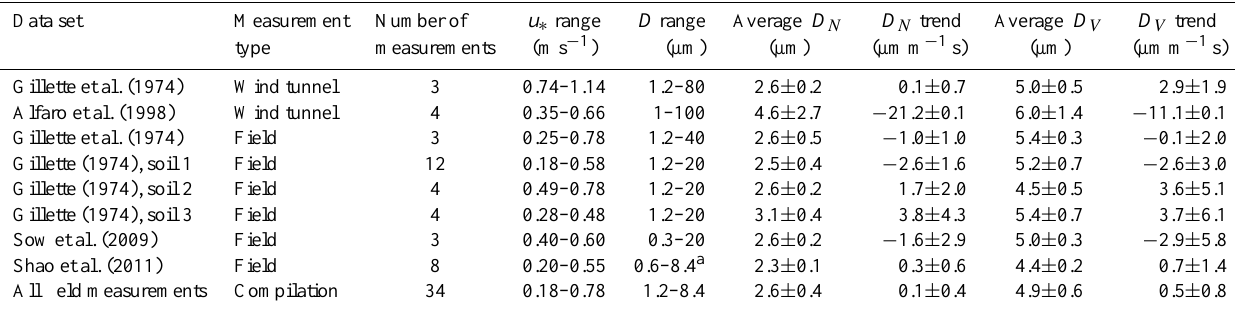
Table 1. Summary of published wind tunnel and field measurements of the size-resolved vertical dust flux. Listed for each data set are the number of measurements, the friction speed and dust aerosol diameter ranges spanned by those measurements, the average D N and D V with standard deviation of those measurements, and the trend with standard error of D N and D V with u ∗ for each data set. This information is also provided for a compilation of all six data sets of field measurements.